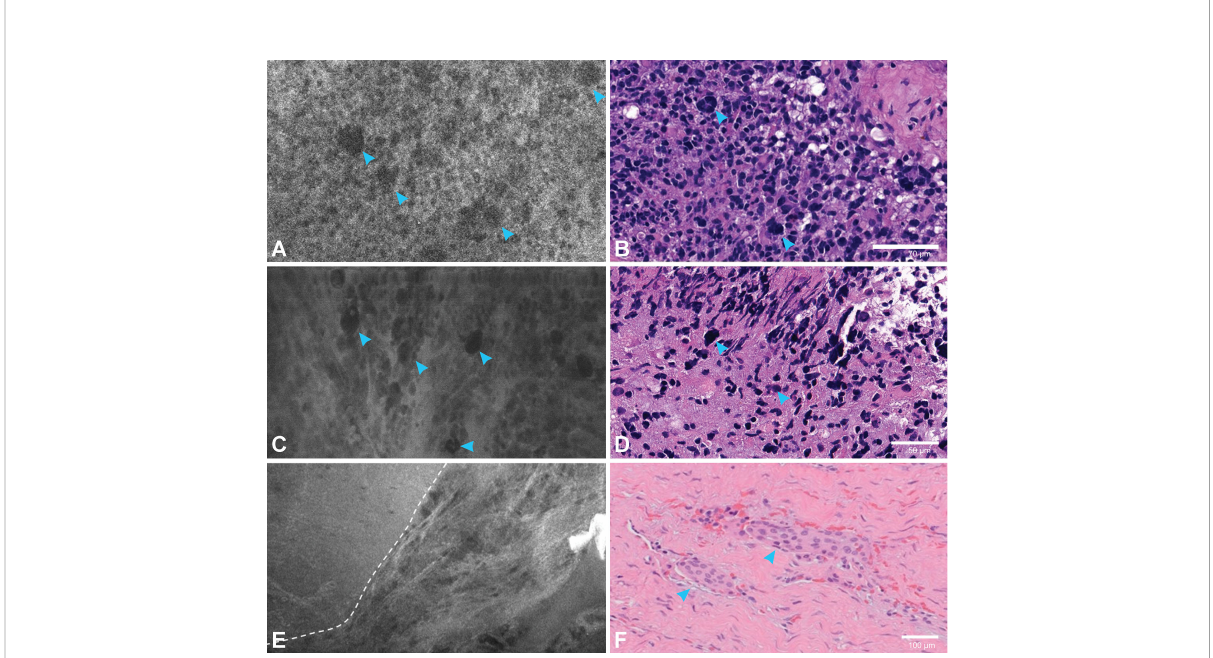
FIGURE 7 Correlation between confocal laser endomicroscopy (CLE) images and permanent hematoxylin and eosin (H&E)-stained sections. An in vivo CLE image from a patient with glioblastoma (A) showing hypercellularity and large atypical cells ( arrowheads ) similar to those in the H&E section ( arrowheads ) (B) . Another ex vivo image from a different patient with glioblastoma (C) with hypercellularity and atypical cells ( arrowheads ) also found in the H&E section ( arrowheads ) (D) . An in vivo image from a patient with meningioma (E) demonstrating the clear transition ( dashed line ) of a nest of tumor cells to acellular fi brous dura tissue, with an H&E section (F) showing tumor cell nests ( arrowheads ) within normal collagenous dura. Used with permission from Barrow Neurological Institute, Phoenix,